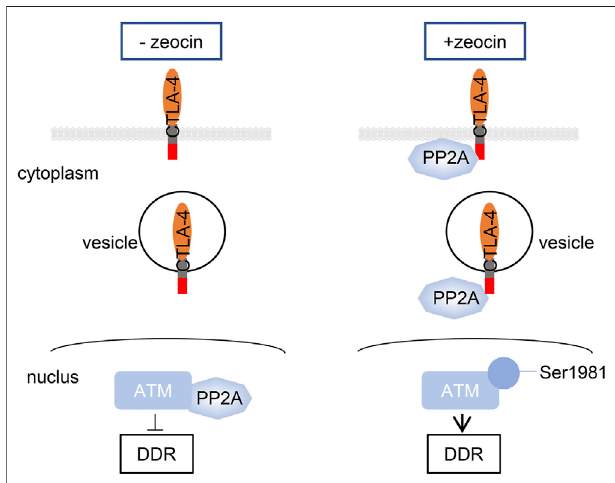
FIGURE7| CTLA-4activatesATMbyanchoringtheATMinhibitorPP2A in the cytoplasm following transient treatment with zeocin in T cells, exacerbating the DNA damage response and inducing